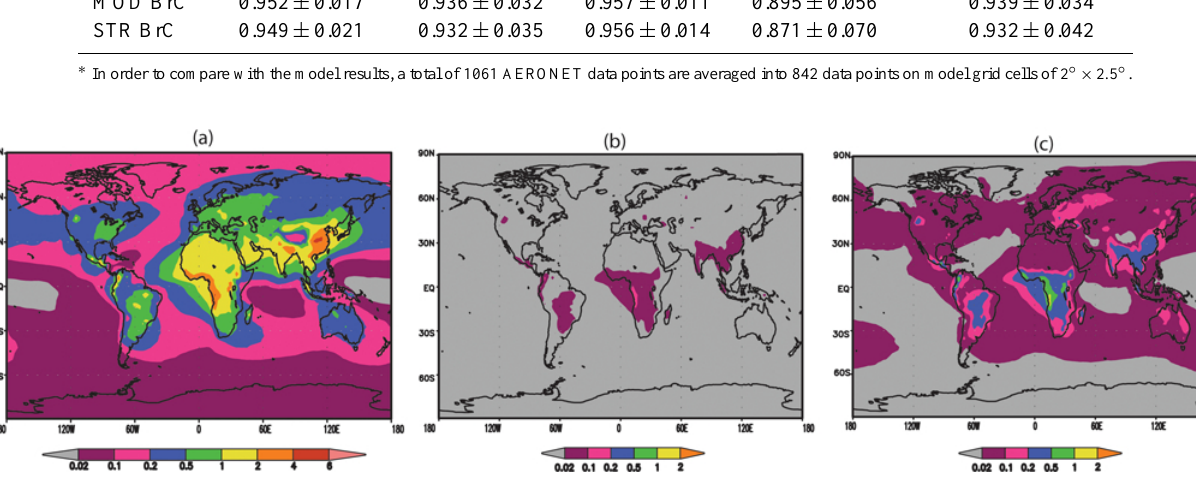
Fig. 5. (a) Annual mean absorption aerosol optical depth (AAOD × 100) calculated with the non-absorbing OC, with increases in AAOD ( × 100) due to the inclusion of the (b) MOD BrC and (c) STR BrC.